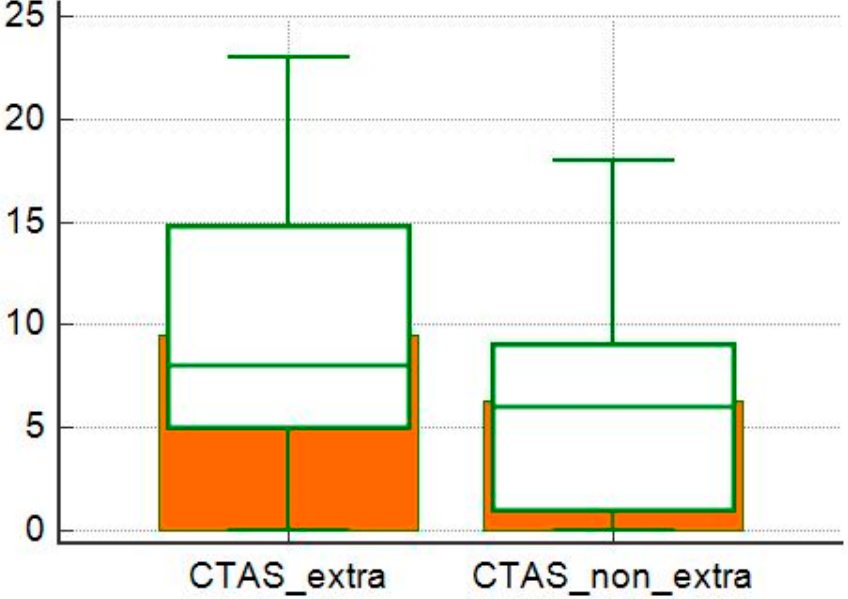
Figure 8. Comparison of CTAS averages between patient with extra-thoracic localization and without extra-thoracic localization.